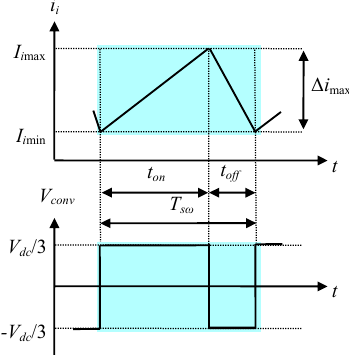
Figure 4. Evolution of the converter current i i and voltage V i .